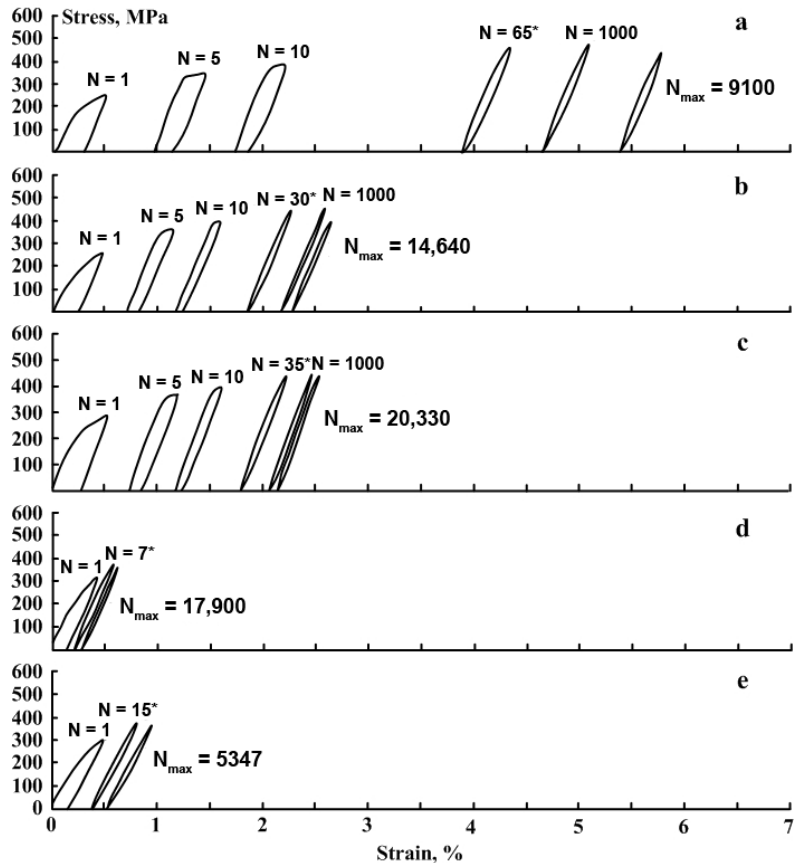
Figure 3. Stress-strain diagrams of the Fe-30Mn-5Si alloy during mechanical cycling ( N is the number of a cycle) after different treatments: ( a )-RHT, ( b )-HR 600 , ( c )-HR 800 , ( d )-CR 500 , ( e )-CR 600 (*—the beginning of the loop closure).